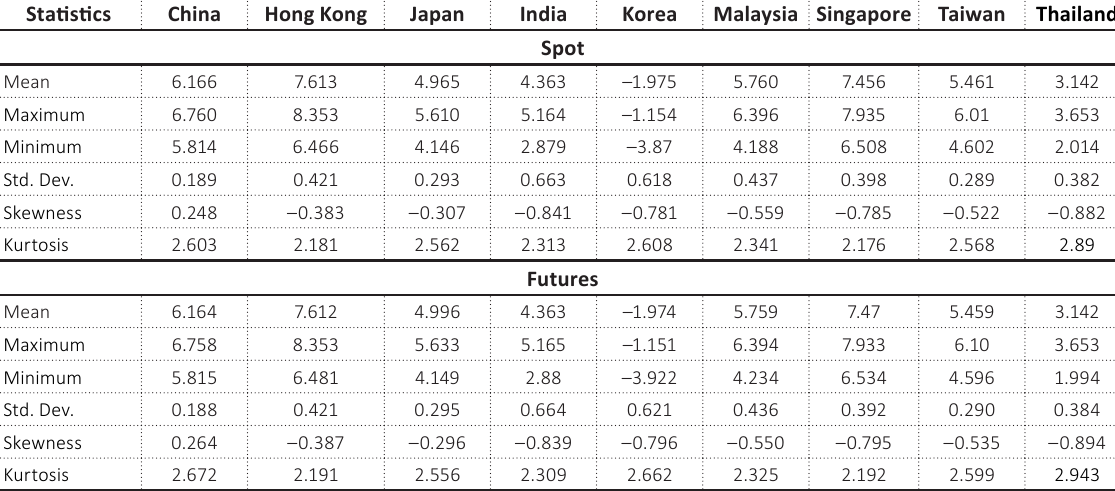
Source: Based on authors’